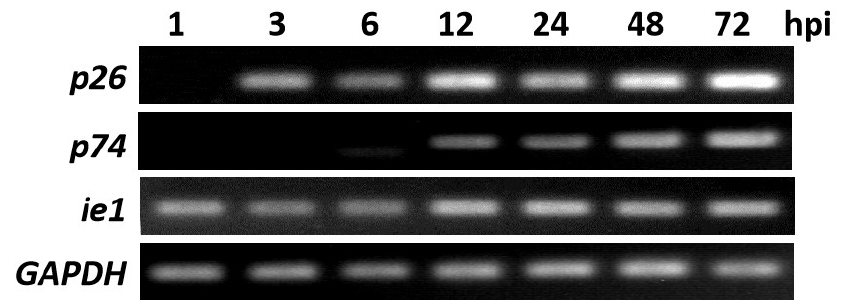
Figure 1. RT-PCR analysis of p26 transcripts in BmNPV-infected BmN cells. RT-PCR was performed by using purified RNA isolated from virus-infected cells at the indicated time points (1, 3, 6, 12, 24, 48, and 72 hpi). The first cDNA strand was synthesized with AMV Reverse Transcriptase and the oligo-p(dT)18 primer, and nested PCR was then performed with the p26 , p74 , and ie1 -specific primers, respectively. gapdh was used as the